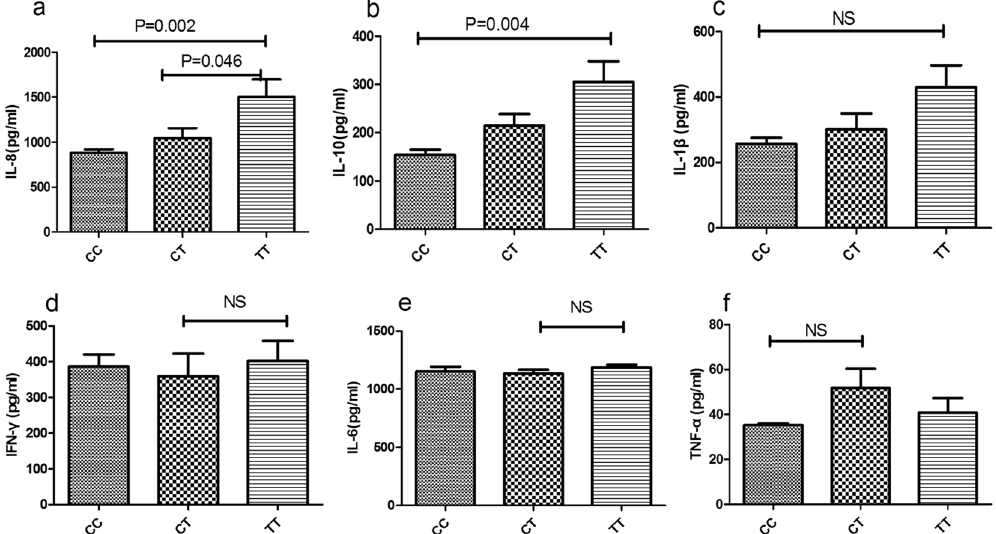
Figure 4. Effect of KLRC4 genotype on cytokine production by LPS stimulated PBMCs from healthy genotyped individuals. IL-8 ( a ), IL-10 ( b ), IL-1 β ( c ), IFN- γ ( d ), IL-6 ( e ) and TNF- α ( f ) were measured by ELISA in the cell culture supernatants. Data are expressed as the mean ± SD (CC = 10, CT = 10, TT =